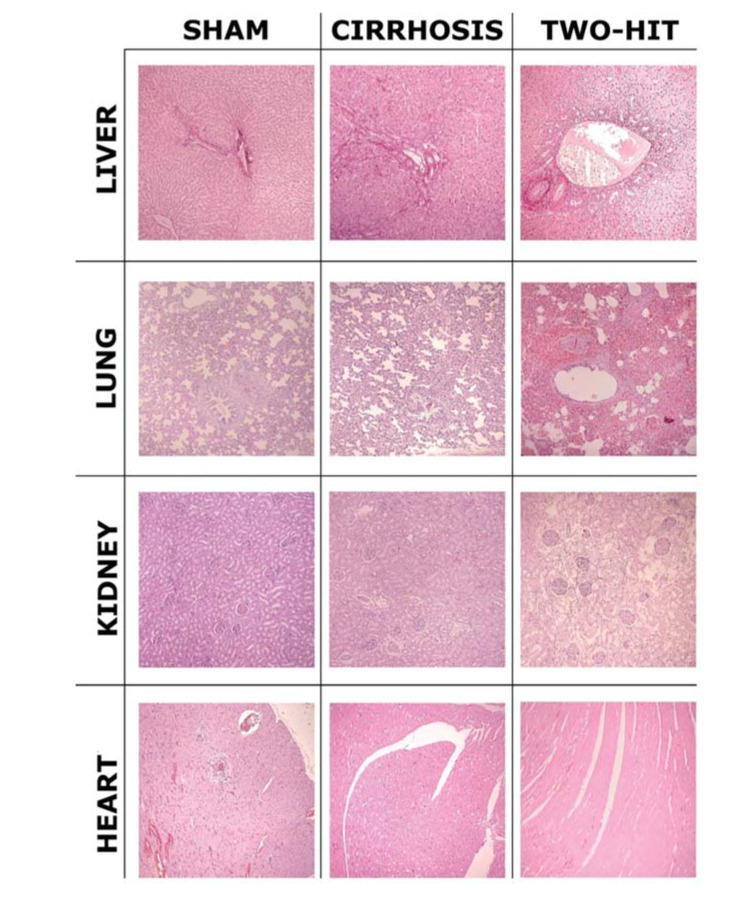
Main histological alterations observed in the experimental animals. In the liver, note that the portal tract is expanded because of intense ductular proliferation. In the lung, note the reduced alveolar space and thickening of pulmonary septa in the BDL+CLP animals. Observe the aspect of renal parenchyma edema in the two-hit animal. No alterations were observed in heart histology. (magnification 100X).